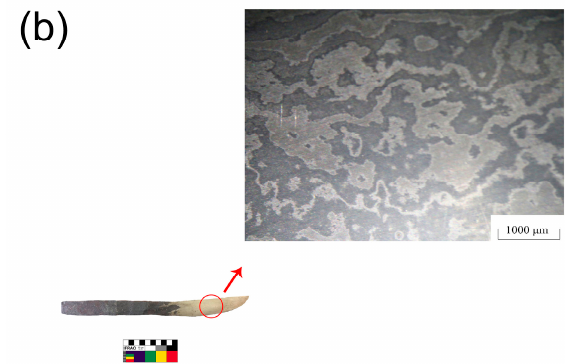
Figure 1. Direct co-fusion to make swords: ( a ) technological process; ( b ) the sword and pattern on the surface.